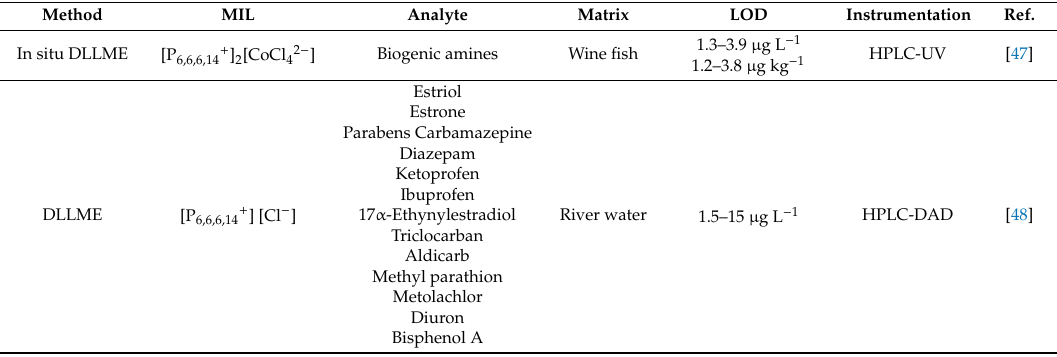
Table 2. Recent applications of magnetic ionic liquids (MILs) for extraction of di ff erent analytes from various matrices. DLLME—liquid–liquid dispersive